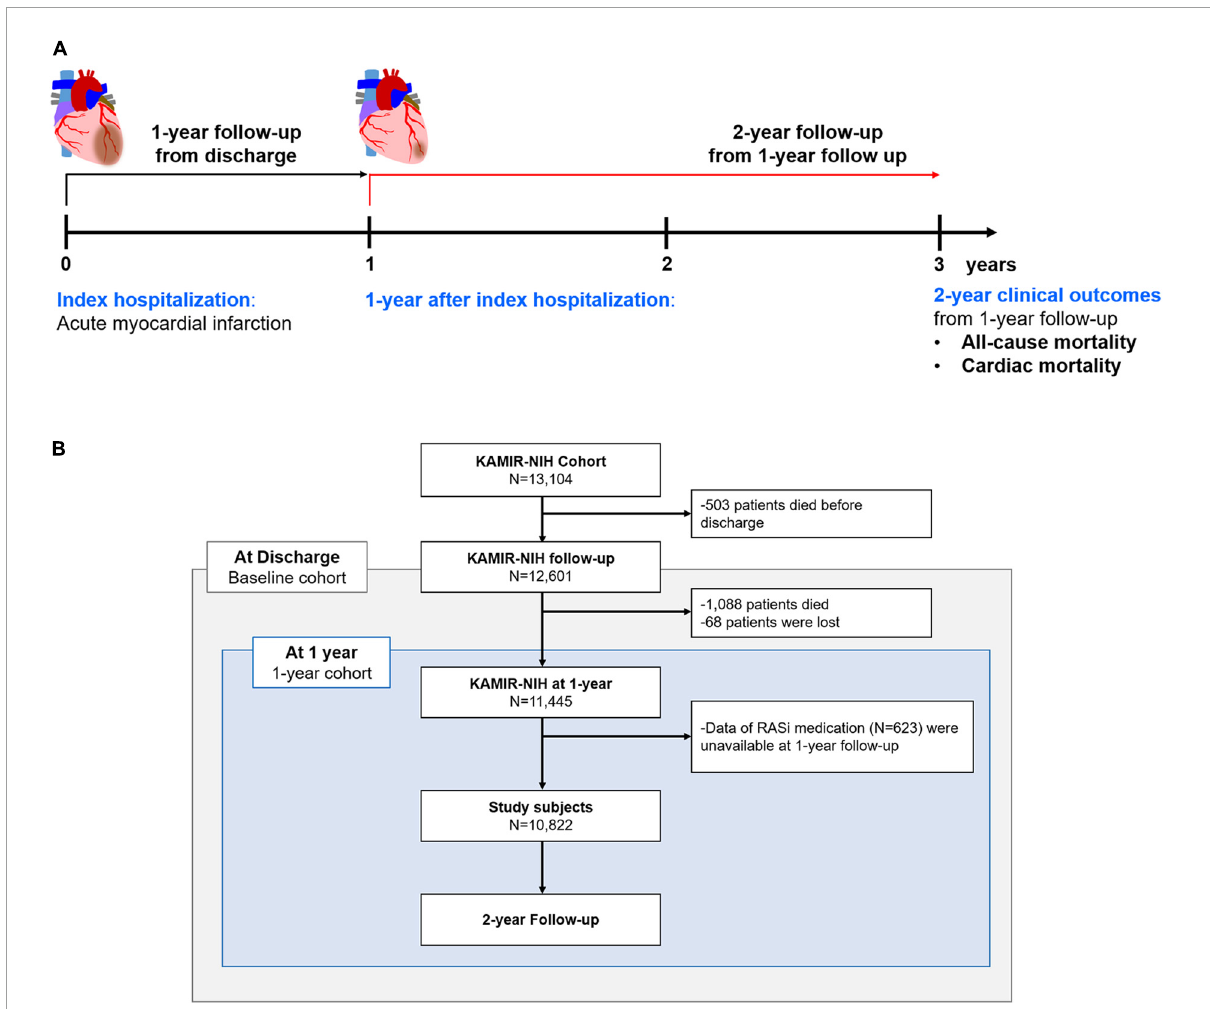
FIGURE1 Study population. Study flow chart (A) and patient demographics based on the flow chart (B) are illustrated. RASi, renin-angiotensin-system inhibitor; KAMIR-NIH, Korean Acute Myocardial Infarction-National Institutes of